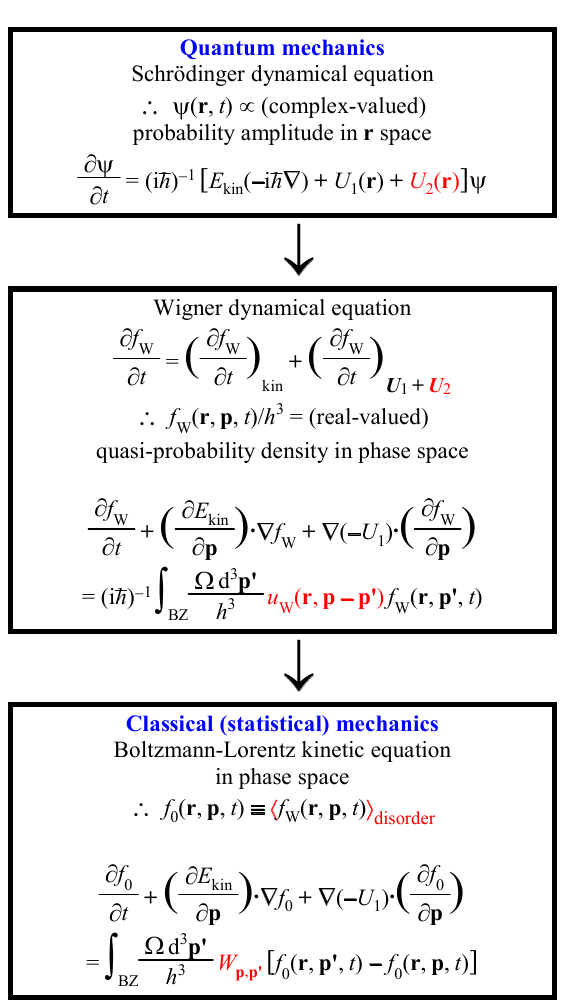
Fig. 1. Organization chart of the article, where the notations of the physical quantities involved will be introduced along the paper. The starting point is Schrödinger’s differential equation governing the complex amplitude of a probability density, i.e. the matter-wave field ψ of a spinless particle. Its Wigner transform f is h 3 times a quasi-probability density in phase W space which is governed by an integro-differential equation. Both the Schrödinger and Wigner equations describe quantum dynamics endowed with phase coherence. The ending point of the article is Boltzmann’s classical-statistical description which makes use of true (phaseless)